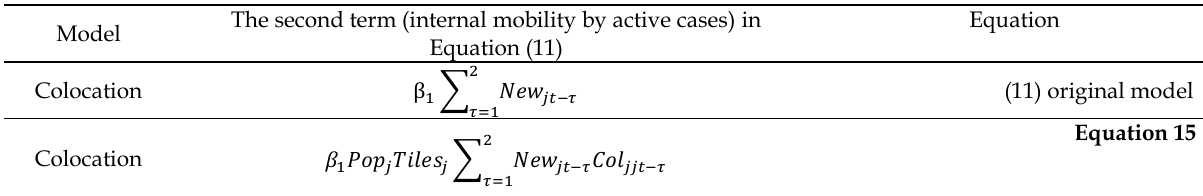
Models with different internal movement